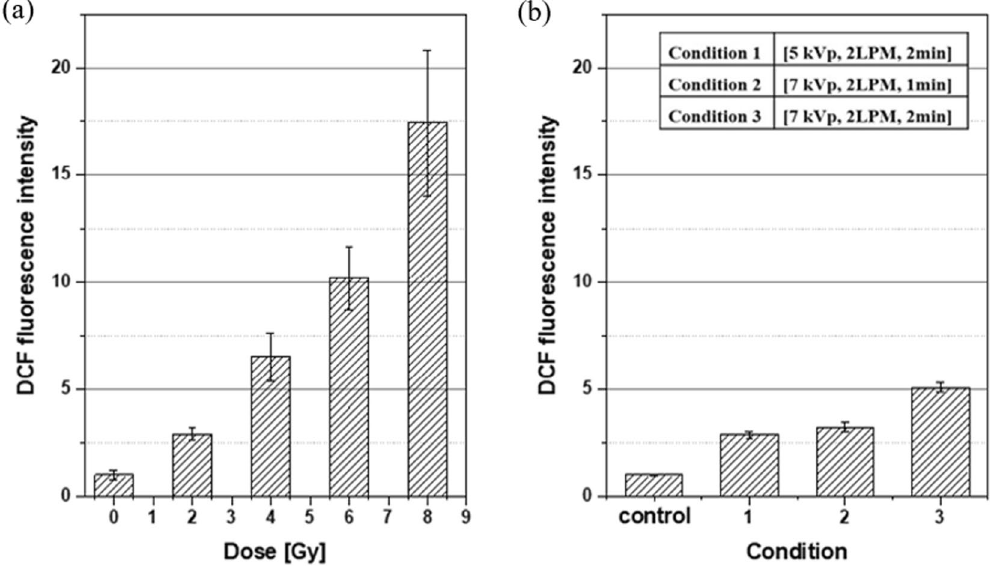
Figure 5. DCF fluorescence intensities varying ( a ) with the X-ray dose and ( b ) under three operating conditions of the APPJ device, both normalized to the control. Each error bar indicates one standard error of the mean obtained from three independent